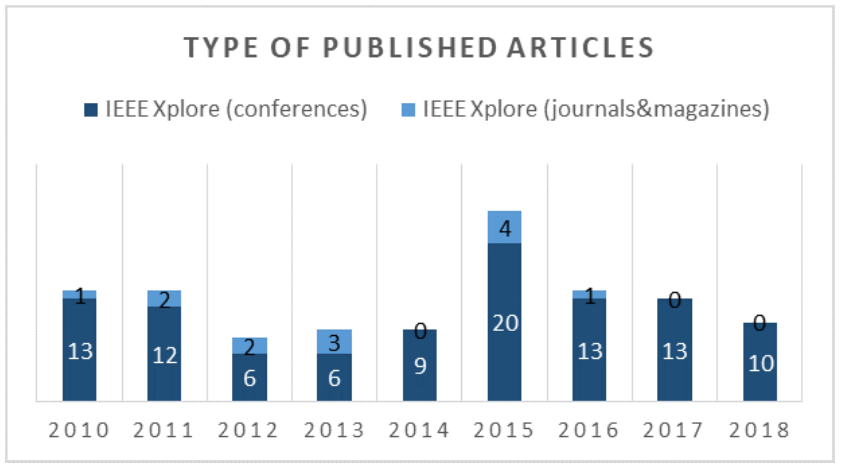
Figure 2. Type of published papers in IEEE resource.